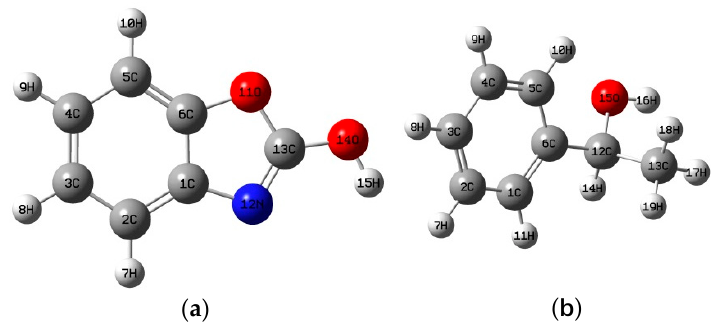
Figure 2. Species a and b of Scheme 1. Figure 2. Species ( a , b ) of Scheme